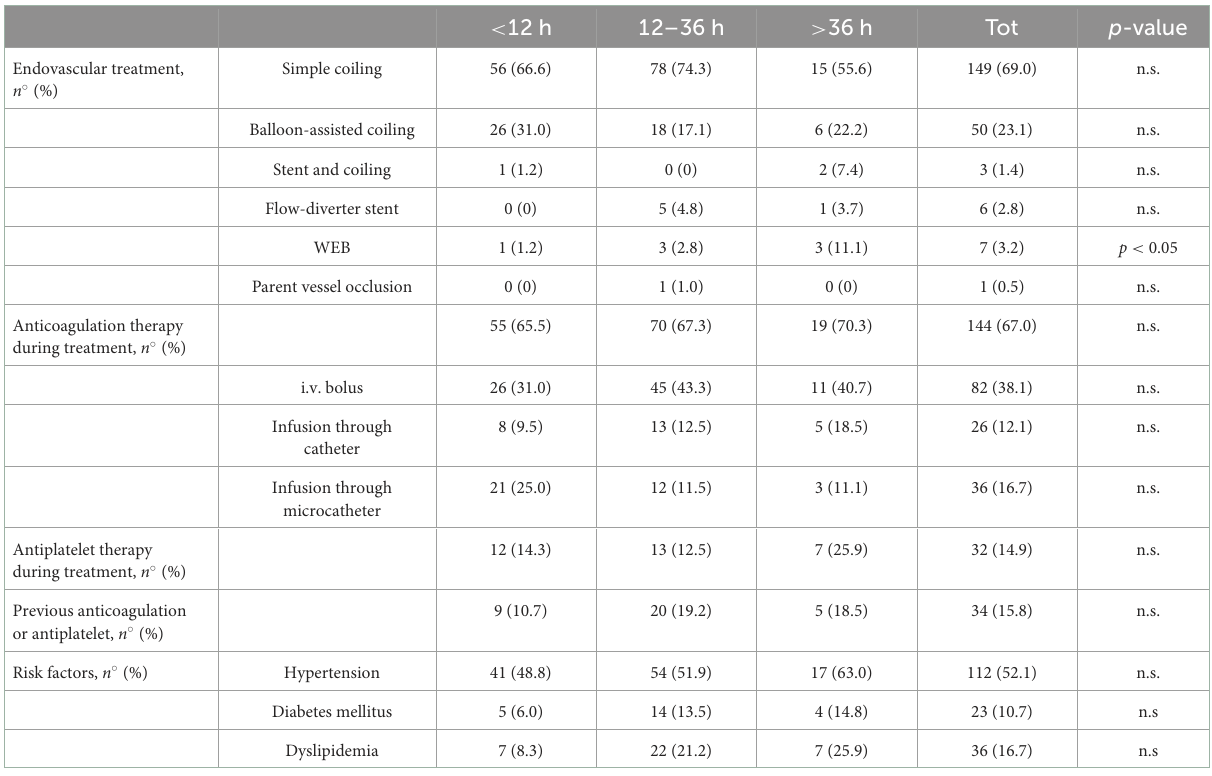
1.484–8.565, p = 0.004, respectively). More in detail, the delayed treatment group showed a higher rate of thrombus formation and thromboembolic events (12 of 27 patients − 44%), compared to hyper-early (17 of 84 patients − 21%; p = 0.037) and early (26 of 104 patients − 25%; p = n.s.) treated patients (Figure 2B). The three treatment groups did not differ significantly for the incidence of aneurysm’s rupture during endovascular treatment: seven of 84 patients − 10%; five of 104 patients − 5%; four of 27 patients − 15%, in the hyper-early, early, and delayed treatment groups, respectively ( p = n.s.; Figure 2C). The complication was resolved in 33 of 66 cases (50%) and only 24 of 215 patients (11%) presented a secondary lesion related to the event. Univariate logistic regression analysis comparing patients with intra-procedural complications and patients with no complications revealed that treatment time from SAH ( χ 2 ; p = 0.041), Hunt and Hess grade ( χ 2 ; p = 0.036), and heparin during procedure ( χ 2 ; p = 0.037) were significantly associated with intra-procedural complications. Variables with moderate to high association, without reaching the significance level, were modified Fisher ( χ 2 ; p = 0.315), rebleeding before treatment ( χ 2 ; p = 0.267), antiplatelets and/or anticoagulant therapy at home ( χ 2 ; p = 0.063), and aneurysm’s location ( χ 2 ; p = 0.207). Interestingly, multivariate logistic